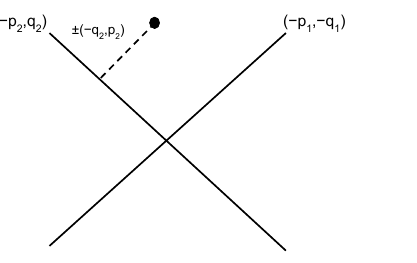
Figure 8 . A probe ( (cid:0) q 2 ; p 2 )-string in the presence of a ( p 2 ; q 2 )-brane. The probe string minimizes its energy when it’s directly atop the brane, since in this case the mass of the open string stretching to it vanishes.